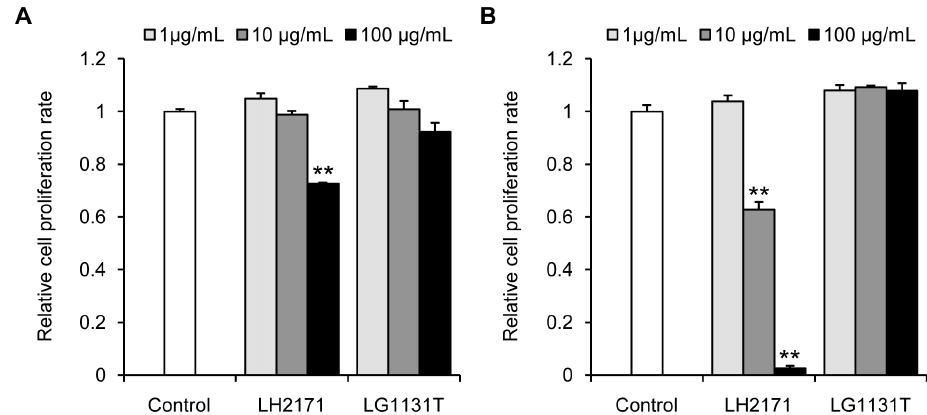
Figure 2. LH2171 suppressed the proliferation of human lymphoma cell lines. Jurkat cells (A) and BJAB cells (B) were cultured in the presence or absence of Lactobacillus helveticus SBT2171 (LH2171) and Lactobacillus gasseri JCM1131 T (LG1131T) for 72 hours. After cultivation, the cell proliferation rate was measured using a Cell Counting Kit-8 (Dojindo, Kumamoto, Japan). Data are expressed as means 6 SEM (n=3) and compared with the control (** P , 0.01) by Tukey-Kramer’s test.